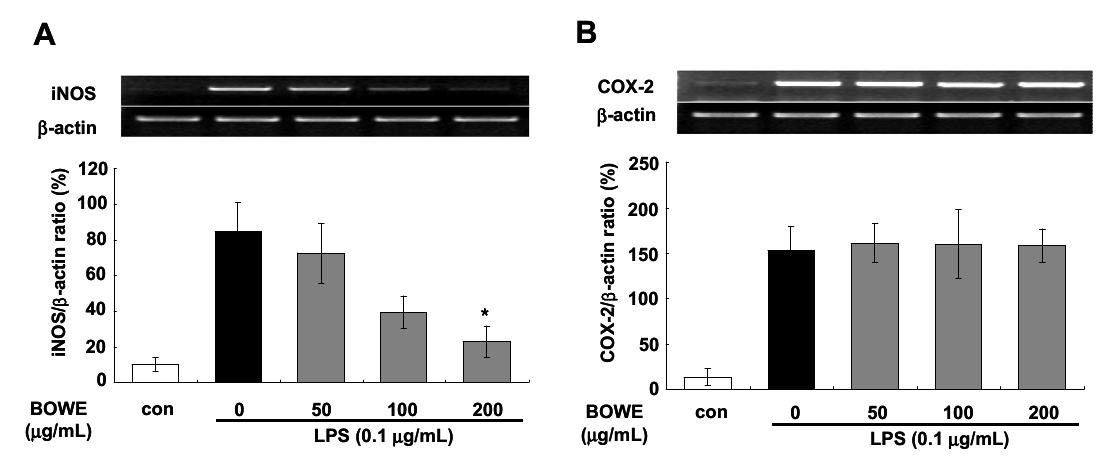
Figure 2. Effect of BOWE on LPS-induced mRNA expression levels of iNOS and COX-2 in BV-2 cells: For mRNA expression, BV-2 cells were pretreated with BOWE for 4 h and then stimulated with LPS (0.1 μ g/mL) for 18 h. Total RNA was isolated, and mRNA levels of iNOS (A) and COX-2 (B) were then measured by RT-PCR. β actin expression was used as an internal control. The quantification of relative band intensities from three independent experiments were analyzed by densitometry and expressed as means ± SEM. * p < 0.01 denotes a significant difference compared to the group treated with LPS